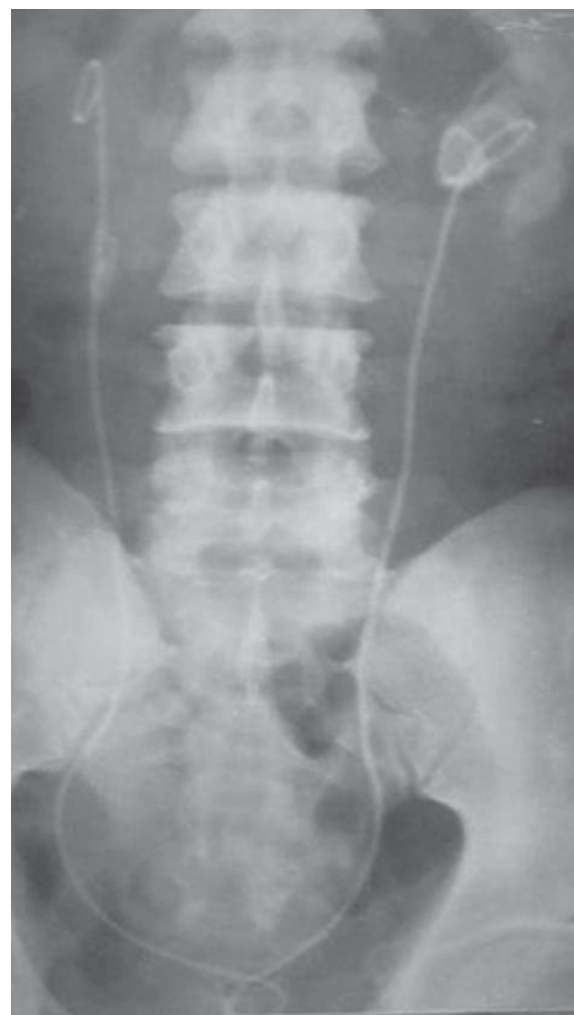
Figure 1 – Plain-film radiography of a patient who presented with renal failure. Left side retained ureteral stent with extensive calcification at the proximal end of the stent. On the right side, a ureteric calculus was seen and a stent was placed preoperatively to normalize serum creatinine